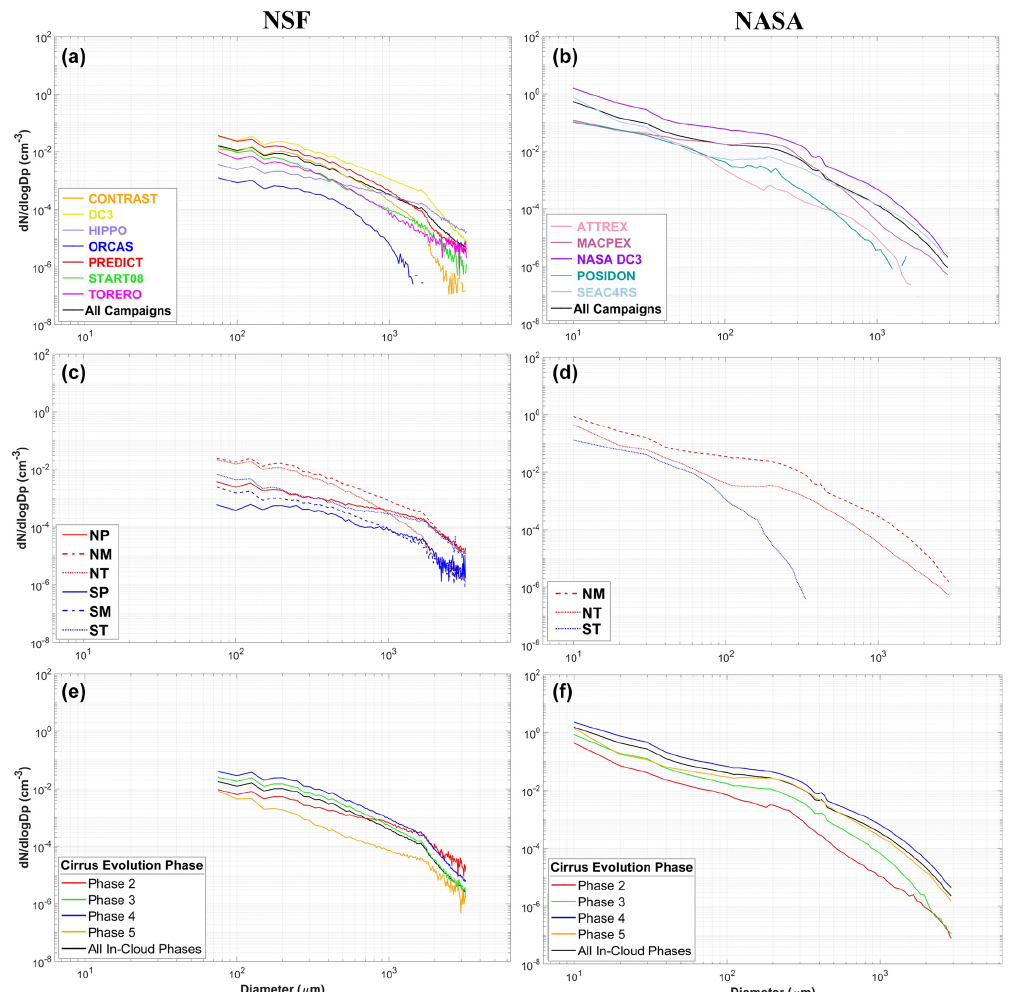
Figure 6. Particle size distribution plots using (a, c, e) the 2DC cloud probe for NSF campaigns and (b, d, f) 2DS probe for NASA campaigns. The data are separated by (a, b) campaigns, (c, d) latitudinal regions and (e, f) the cirrus cloud evolution phases. d N/ dlogD p is the average particle number concentration in each bin normalized by the log 10 -scale bin